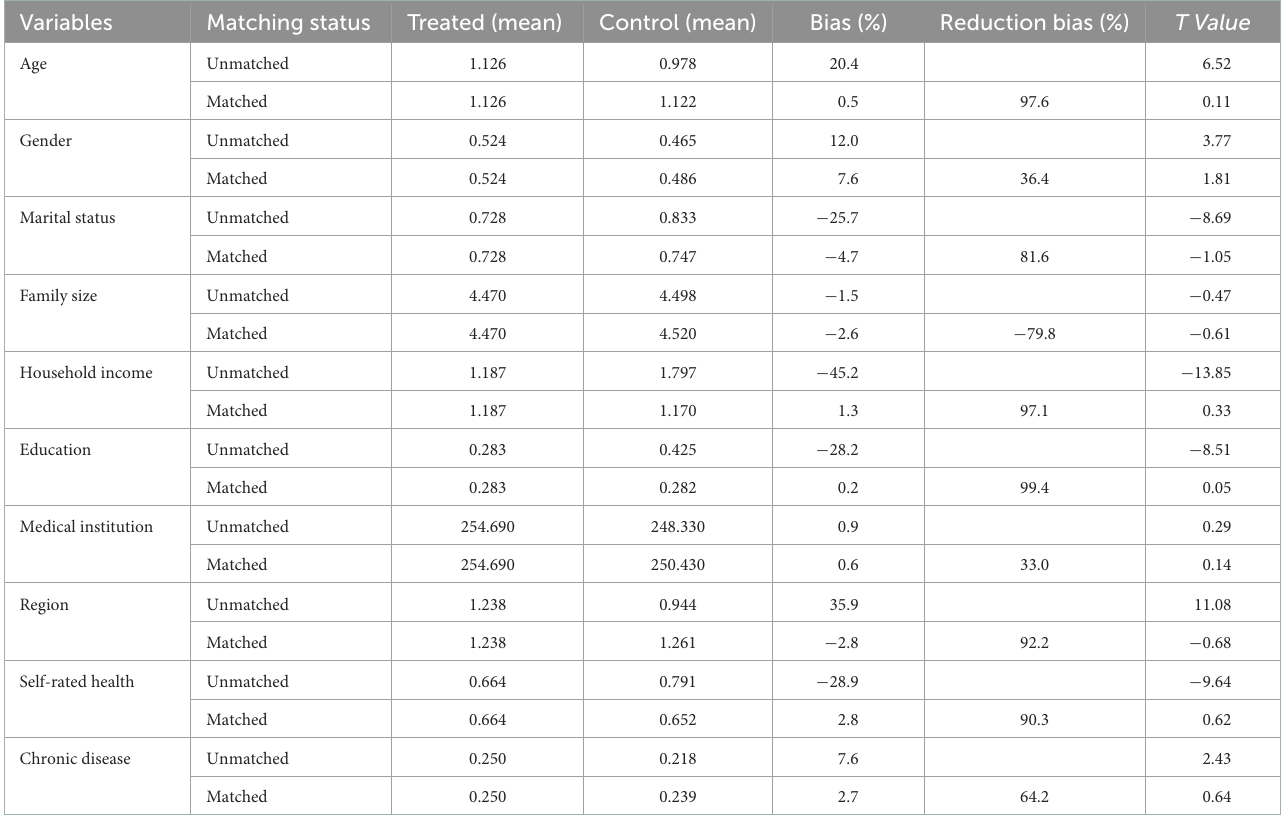
TABLE 2 The matching quality of the propensity score matching (PSM)